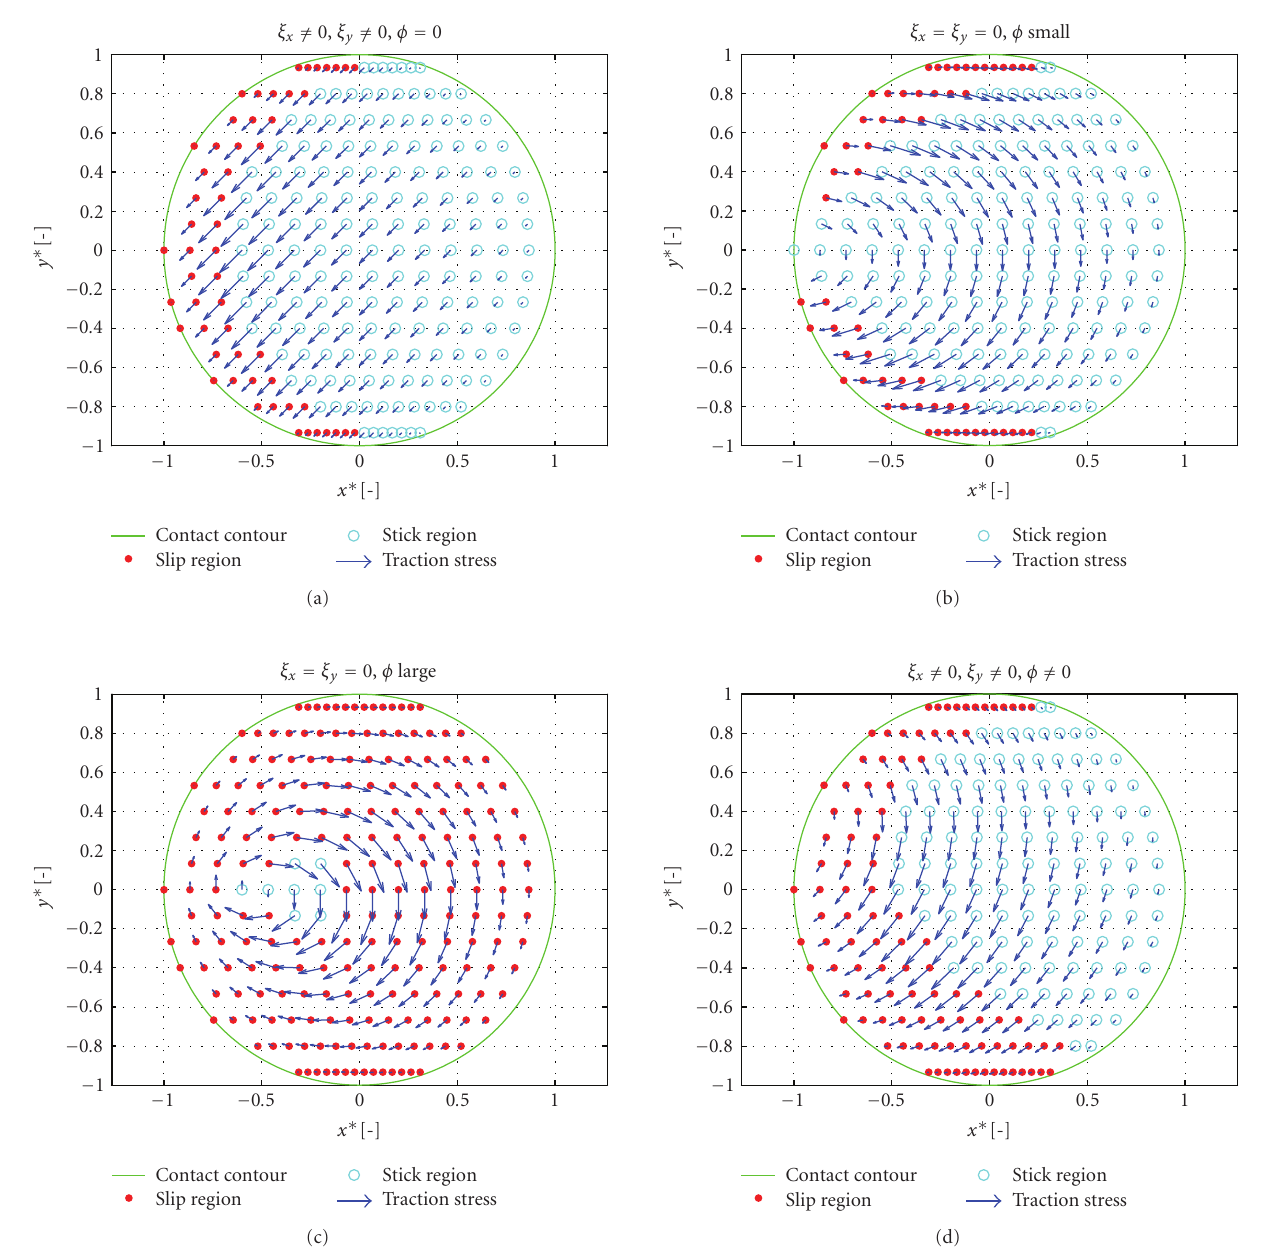
Figure 9: A few results of the steady-state rolling traction field, the rolling direction is from the left to the